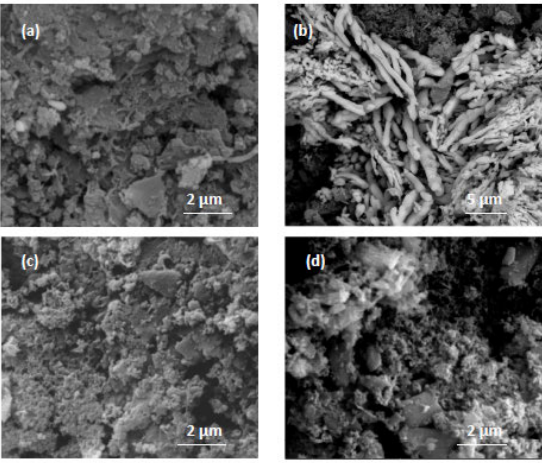
Fig. 12 SEM images of ZrB 2 –SiC from (a) and (b) ZSBC3.3+24 wt% Mg, (c) ZSBC3.3+40 wt% Mg, and (d) ZSBC2.5+40 wt% Mg after FT assisted synthesis and leaching with 1.5 M HCl.